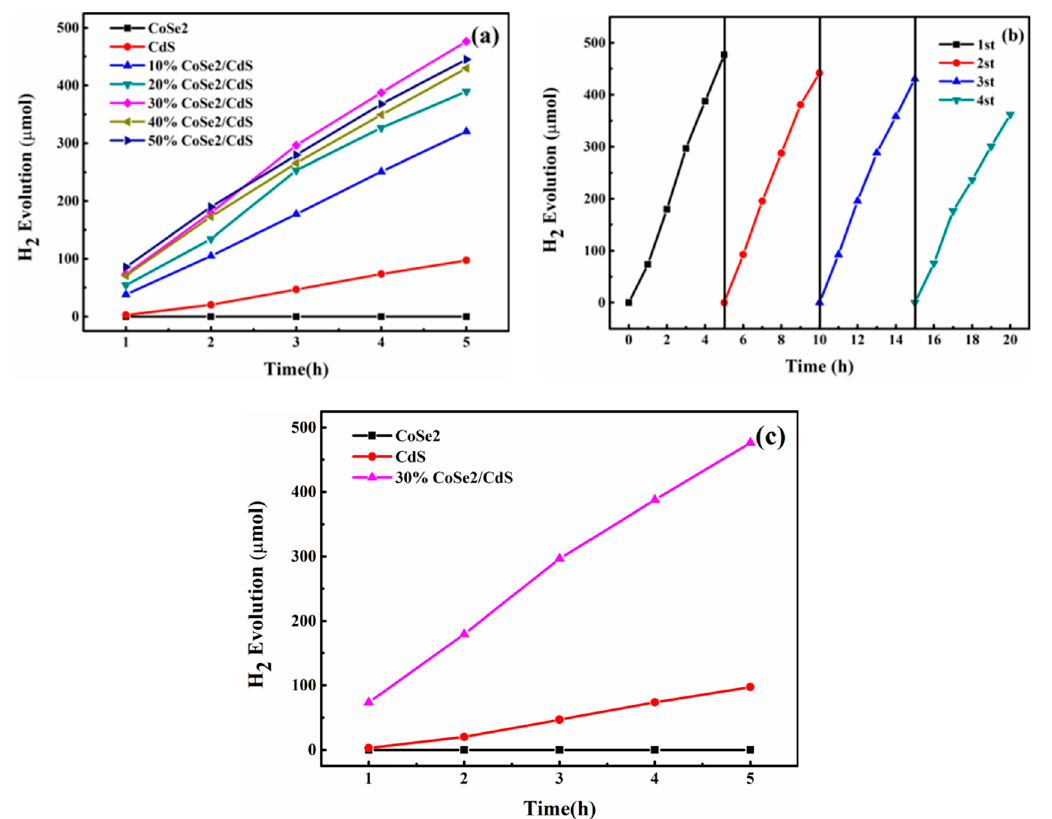
Figure 5. Research of hydrogen evolution activity: ( a ) The hydrogen evolution activity of pure CdS, CoSe 2 and CoSe 2 / CdS ranging from 10–50%; ( b ) four repeating cycles of 30% CoSe 2 / CdS; and ( c ) the hydrogen evolution compare.